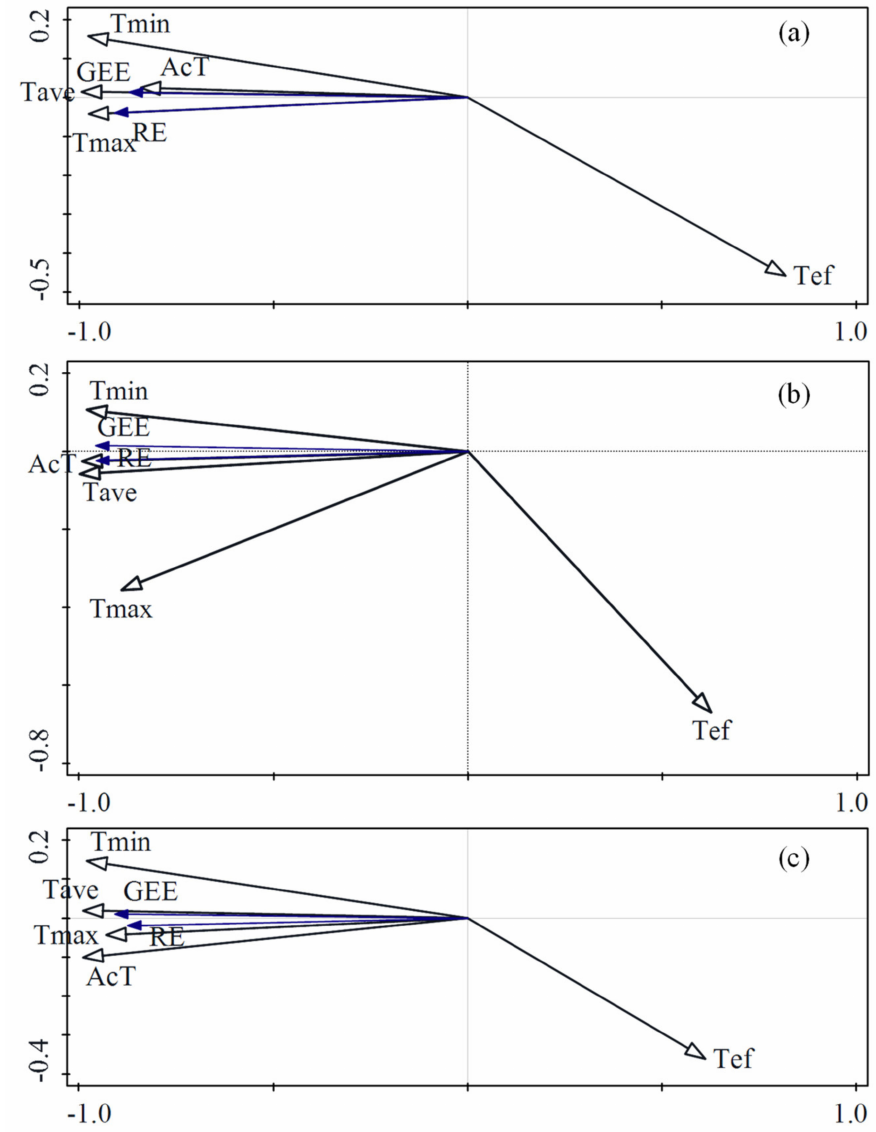
Figure 7. Redundancy analysis of temperature index with ecosystem respiration and gross ecosystem exchange in temperate grassland ( a ), subtropical artificial coniferous forest ( b ), and tropical rain forest ( c ). Note: RE is ecosystem respiration, GEE is gross ecosystem